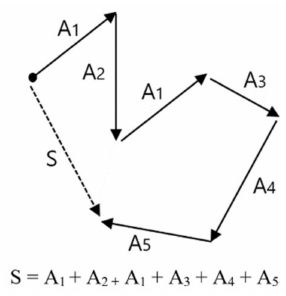
Figure 6. Concept of vector summation, which is the basic operation of vectorized EEG